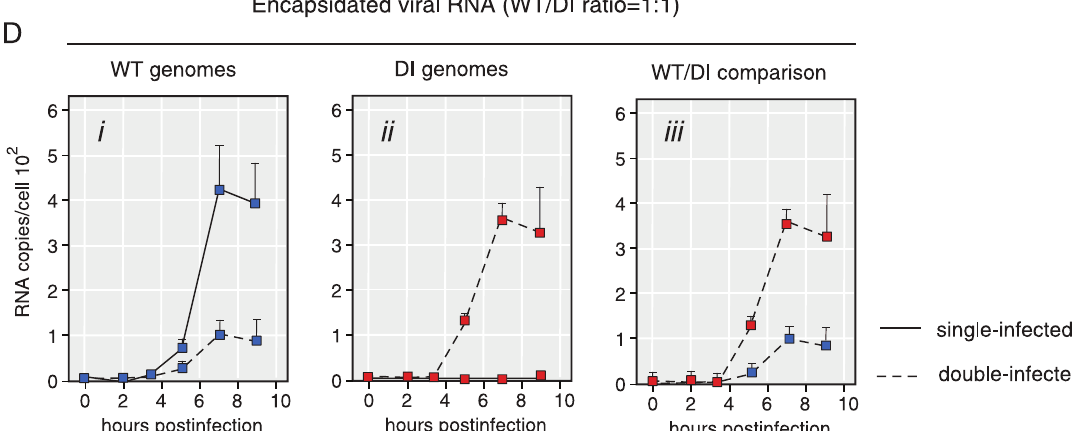
Fig 1. DI genomes inhibit WT virus production via genomic replication and encapsidation. (A) Structure of the WT poliovirus, DI ( Δ 1175–2956), and DI( Δ 1175–2956)(Rep-). The DI genome has an in-frame deletion in its P1-encoding region. The PvuII-cut DI genome is used for a non-replicating RNA control (Rep-). (B) Growth curves of WT poliovirus after transfection of WT genomes and/or DI genomes (sampling time-points: 0, 3, 6 and 9 hours after transfection). (C, D) Copy numbers of total (C) or encapsidated (D) genomes over time after transfection (sampling time-points: 0, 2, 3.5, 5, 7 and 9 hours post transfection). Blue and red squares indicate